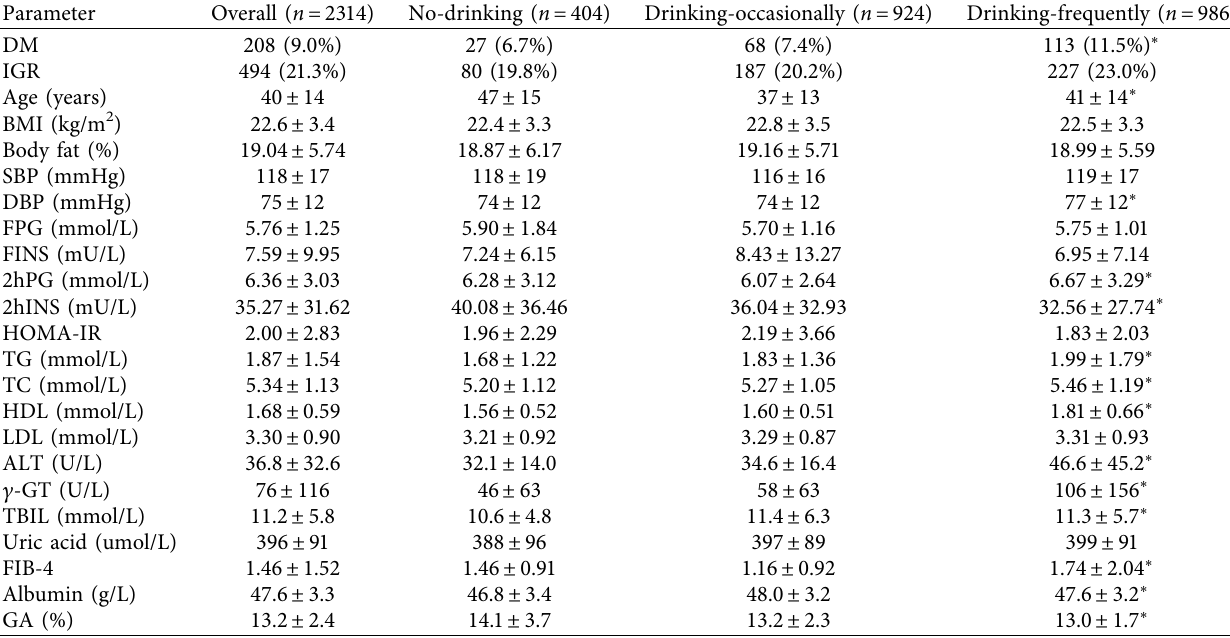
Table 1: Clinical characteristic by drinking status.